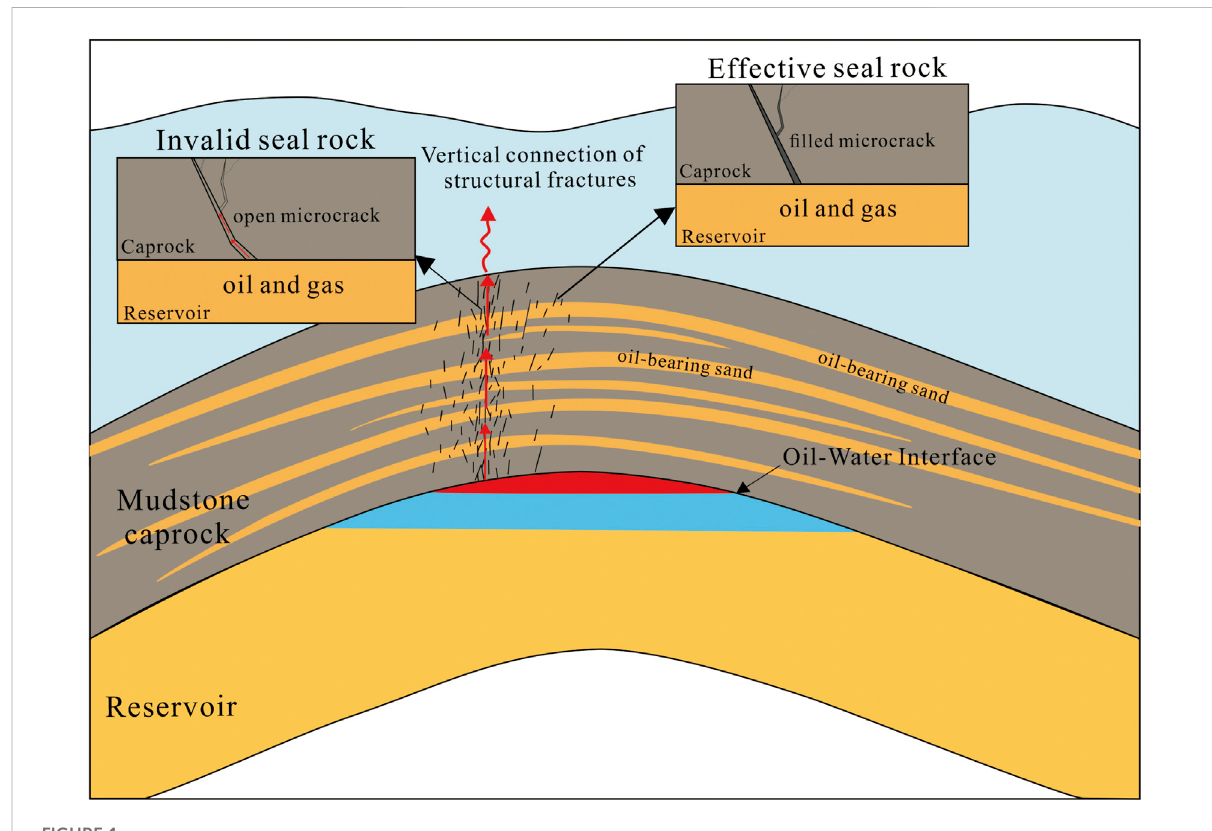
FIGURE 1 Schematic diagram of micro-crack damage to